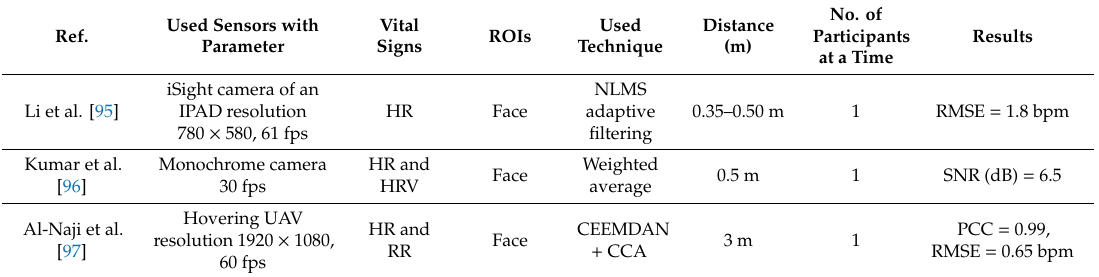
Table 4. iPPG based methods concern about both illumination variations and motion